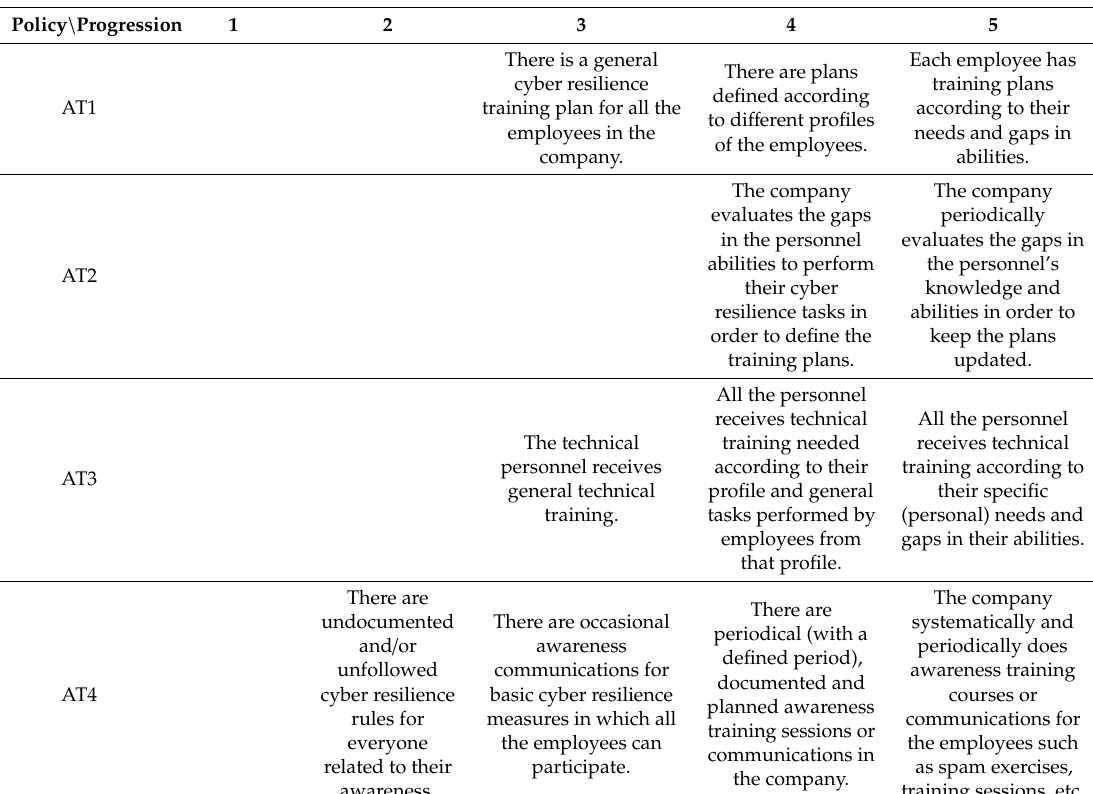
Table 19. Awareness and training policies’ progression